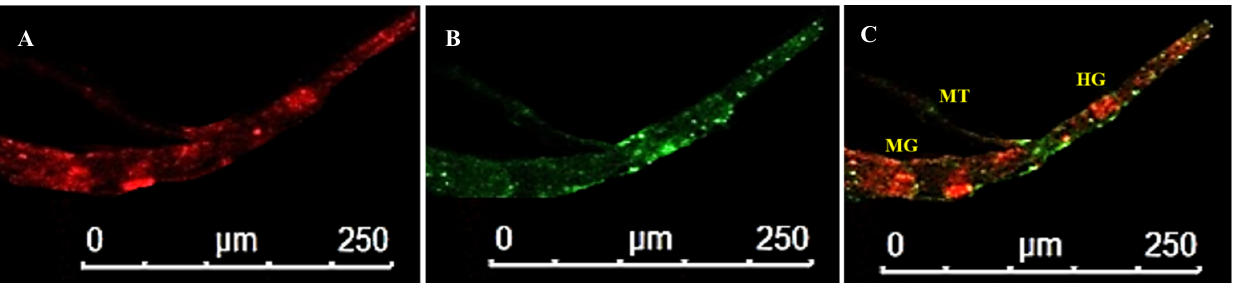
Figure 7. Accumulation of WBNV in TSG and alimentary canal during P2 stage of Thrips palmi . ( A ). Alexa Fluor 594 phalloidin-conjugated F-actin probe red fluorescence ( B ). FITC-conjugated goat anti-rabbit secondary antibody green fluorescence indicating WBNV-N protein ( C ). Merged image of red and green fluorescence signals. MG1—midgut 1; TSG—tubular salivary gland. TSG meets the alimentary canal at the junction of MG1 and MG2. WBNV infection in TSG was prominent in P2 8 days post acquisition.